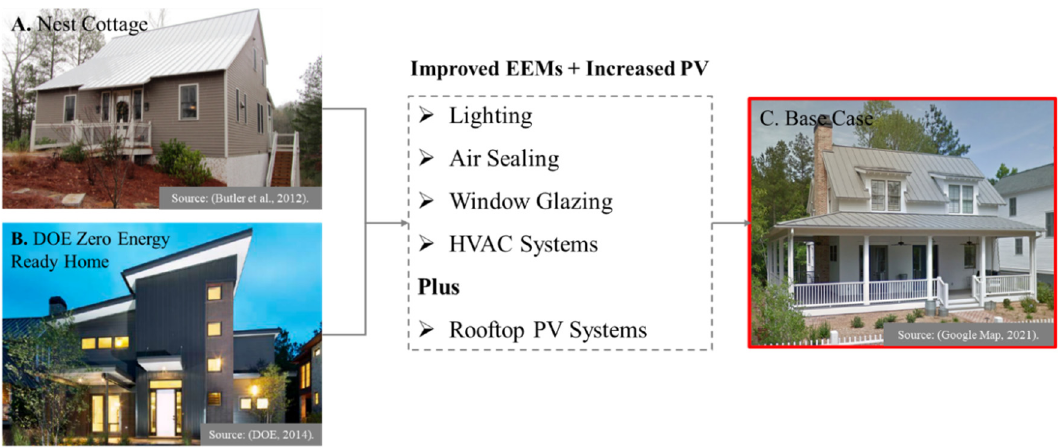
Figure 8. Main parameters in energy efficient buildings in Serenbe. Source: Butler et al. [36], DOE (2014) [35], modified from Google Maps 2021.